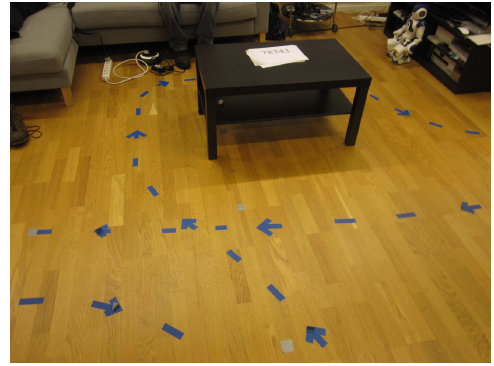
Figure 7. Example of experiment path (detail)